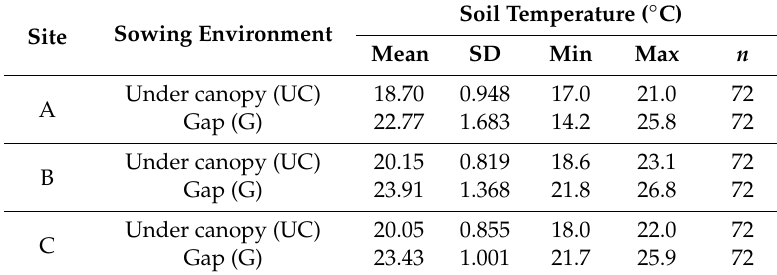
SD = Standard deviation, n = number of temperature measurements (three measurements for each plot × 24 plots =